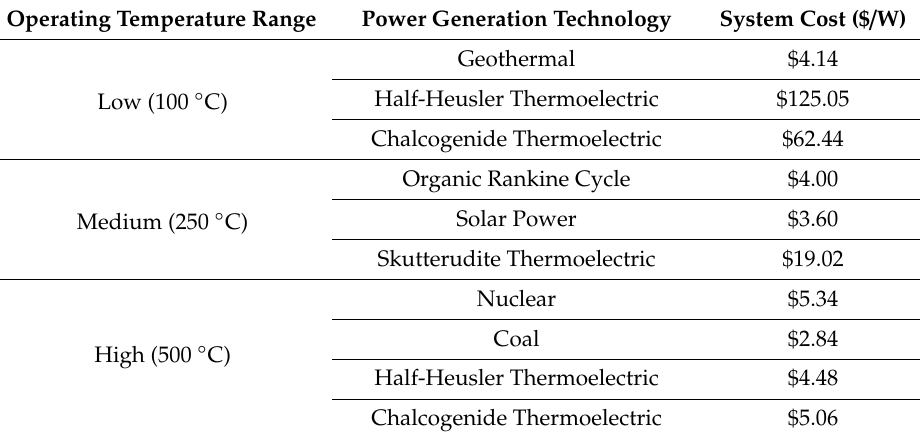
Table 5. Cost of power generation technologies.